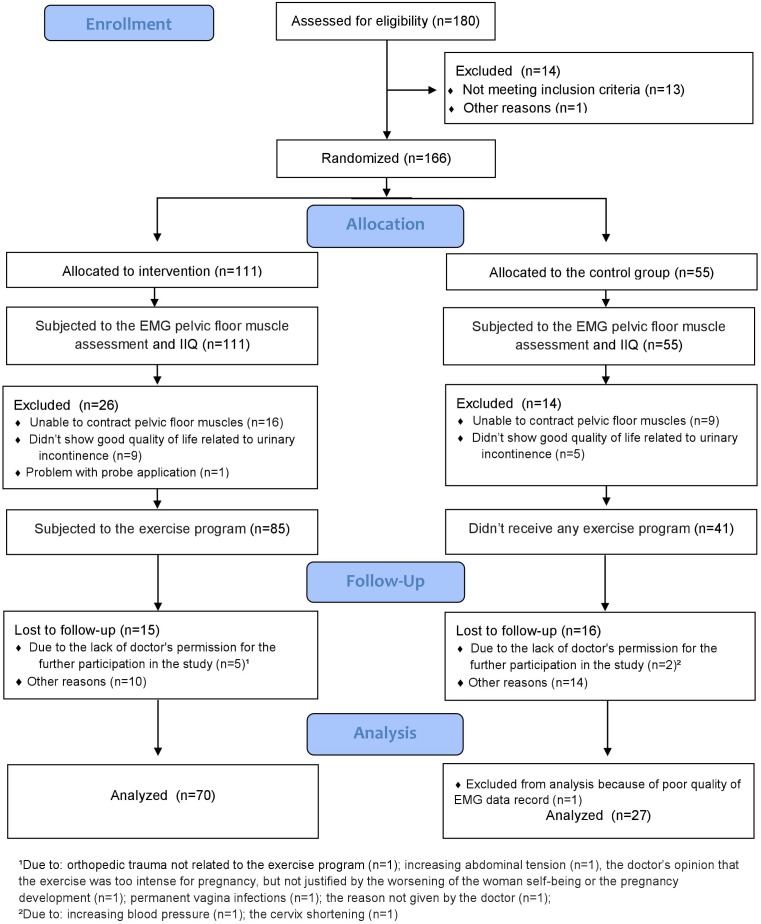
The flow of participants through the study.